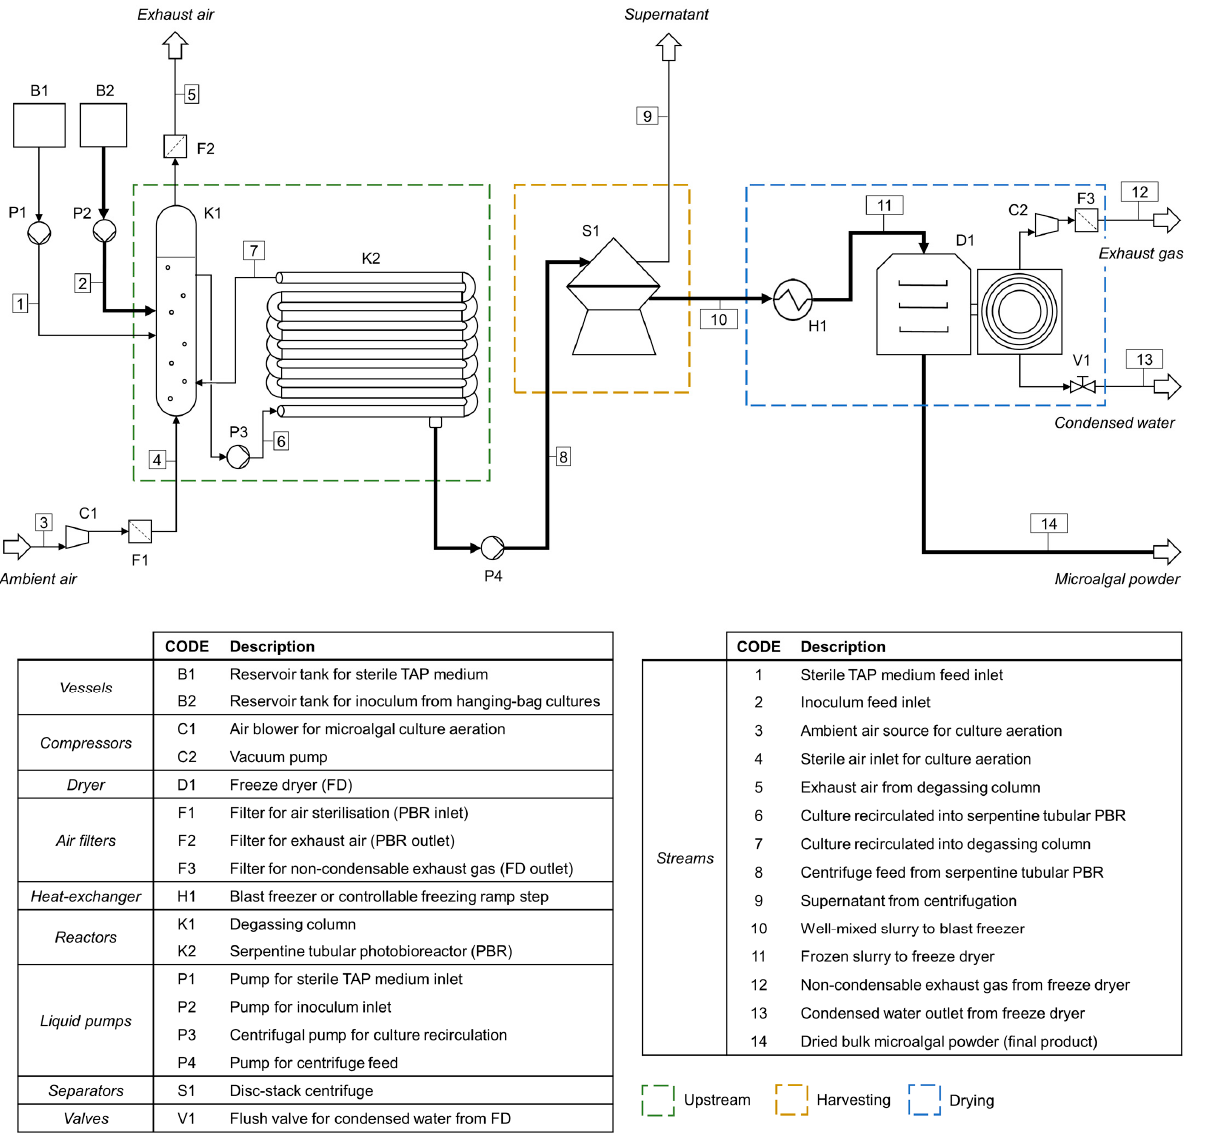
Figure A1. Process flow diagram of the production of a microalgae-based edible vaccine with a freeze-drying strategy.